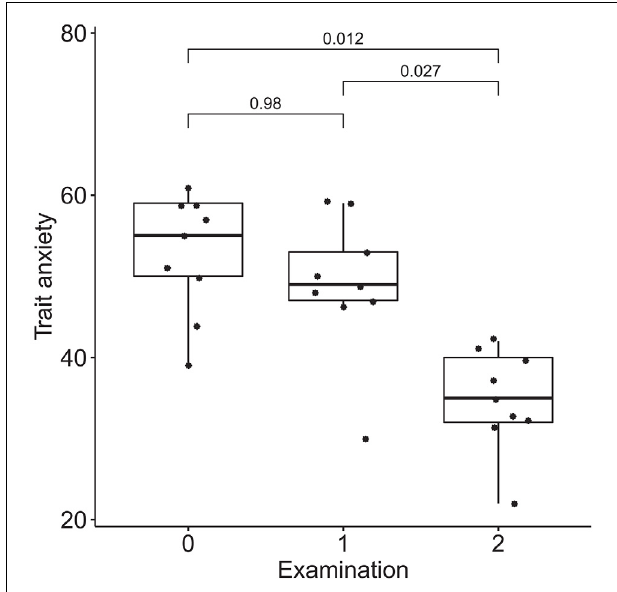
FIGURE 9 | Dynamics of trait anxiety after the course of infra-low frequency neurofeedback. The examination was performed three times: (0) 2 to 4 months before enrollment, (1) at enrollment; and (2) after the neurofeedback course. Significance for the Wilcoxon pairwise comparisons is presented on the plot ( p -value, Bonferroni corrected).